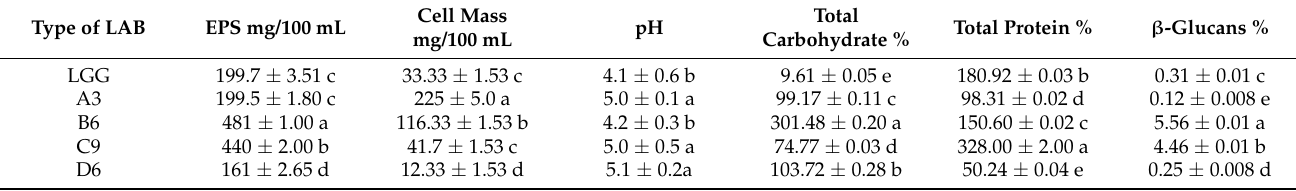
Table 3. The screening of LAB isolates to produce β -glucans under different parameters using LGG as a